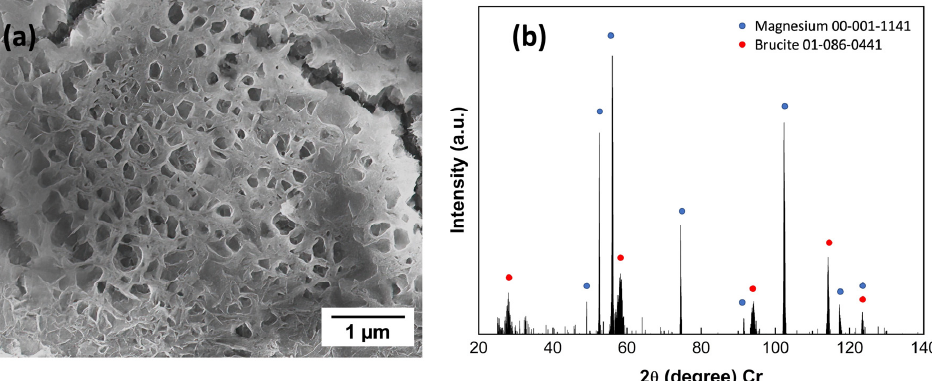
Figure 12. ( a ) SEM images on ZEK100 Mg side of micro-pits within grains; ( b ) XRD result of the corrosion product.